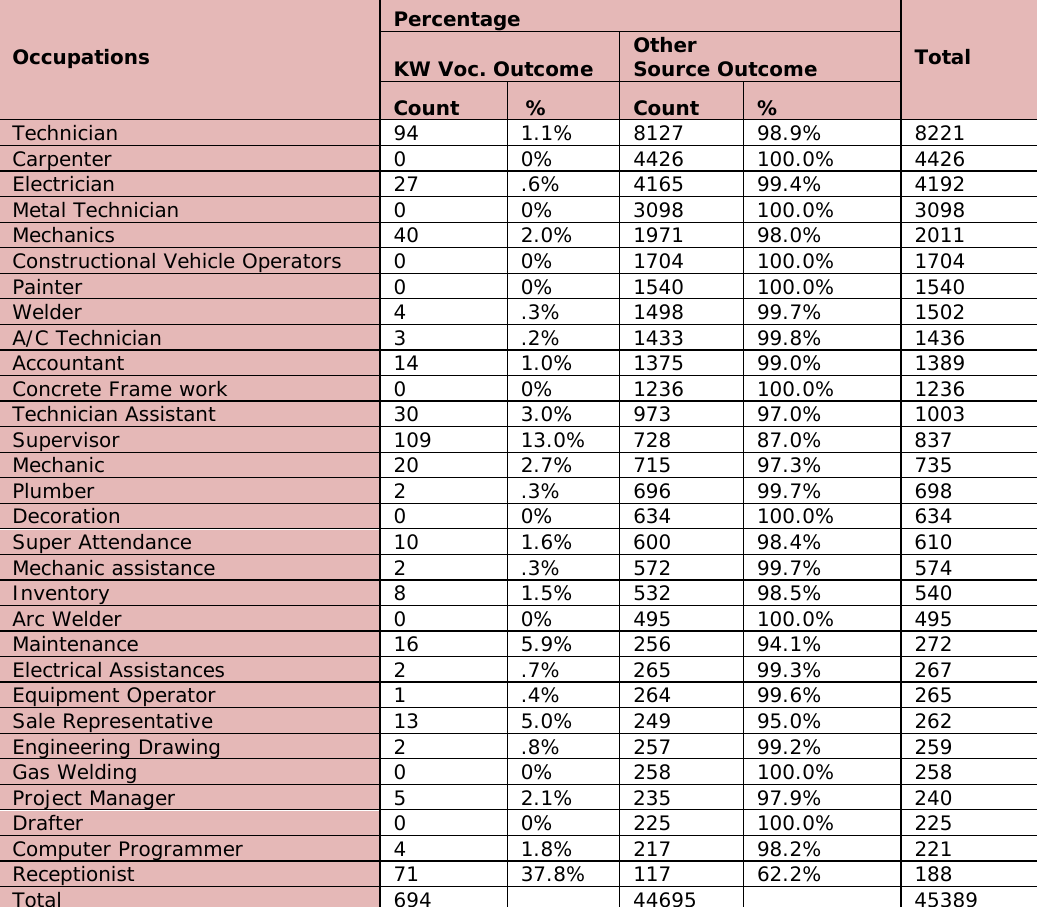
Table 1. “Percentage of the vocational outcomes in the private sector in Kuwait